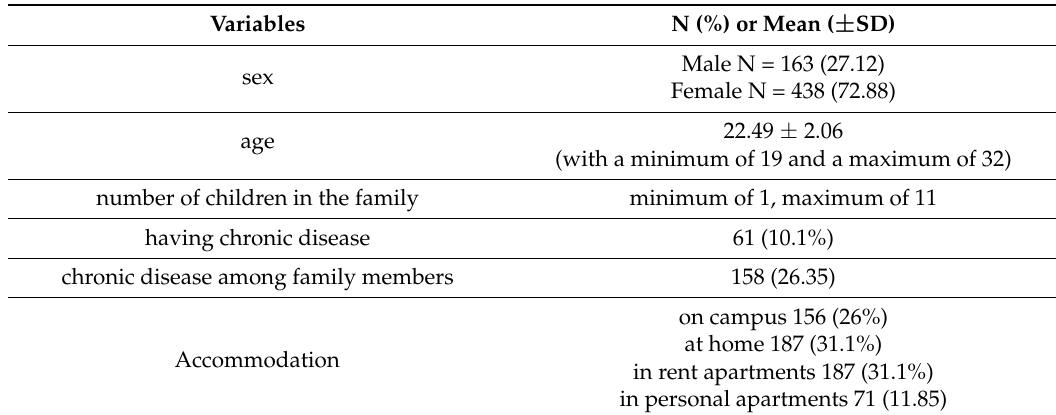
Table 2. Socio-demographic